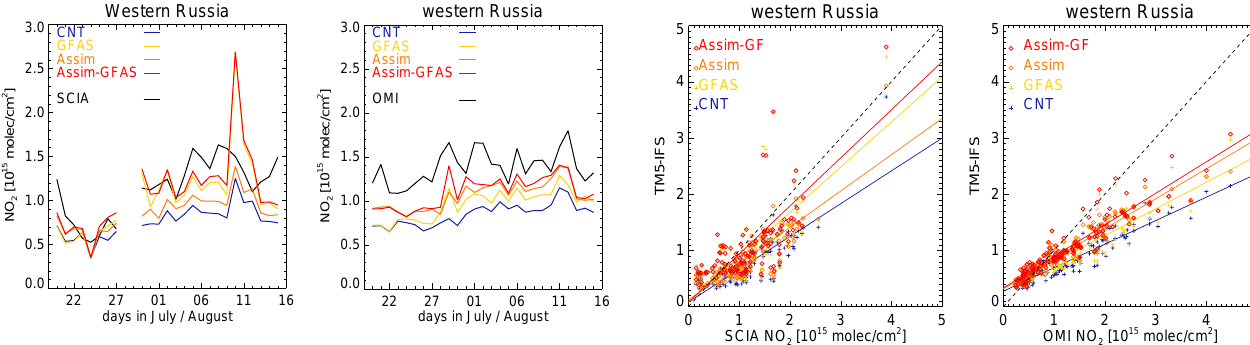
Fig. 14. Scatter plots of mean tropospheric NO 2 for model runs at D+0 with respect to observations from SCIAMACHY and OMI, for the period 20 July to 15 August